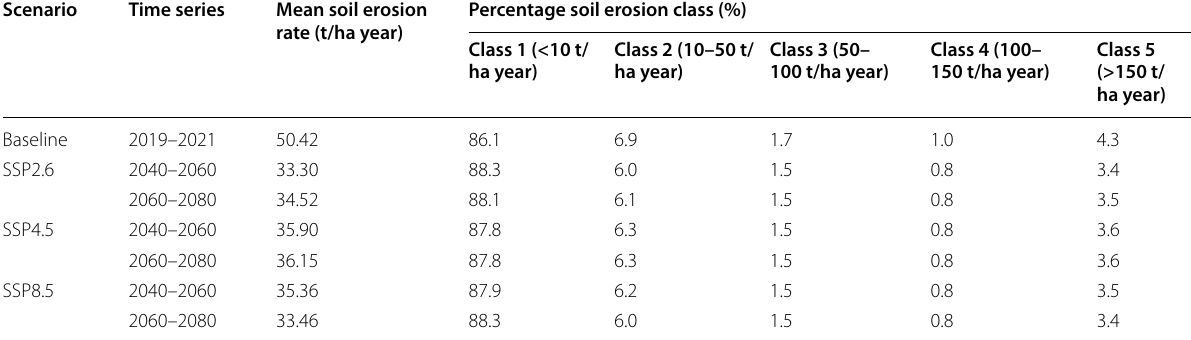
Table 4 Zonal statistical (average t/ha year) for each soil erosion classes under baseline and estimated SSP scenarios Scenario